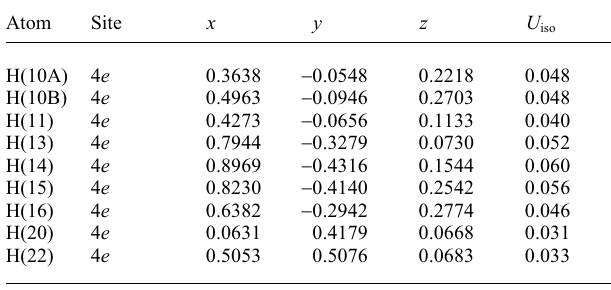
Table 3. Atomic coordinates and displacement parameters (in Å 2 )